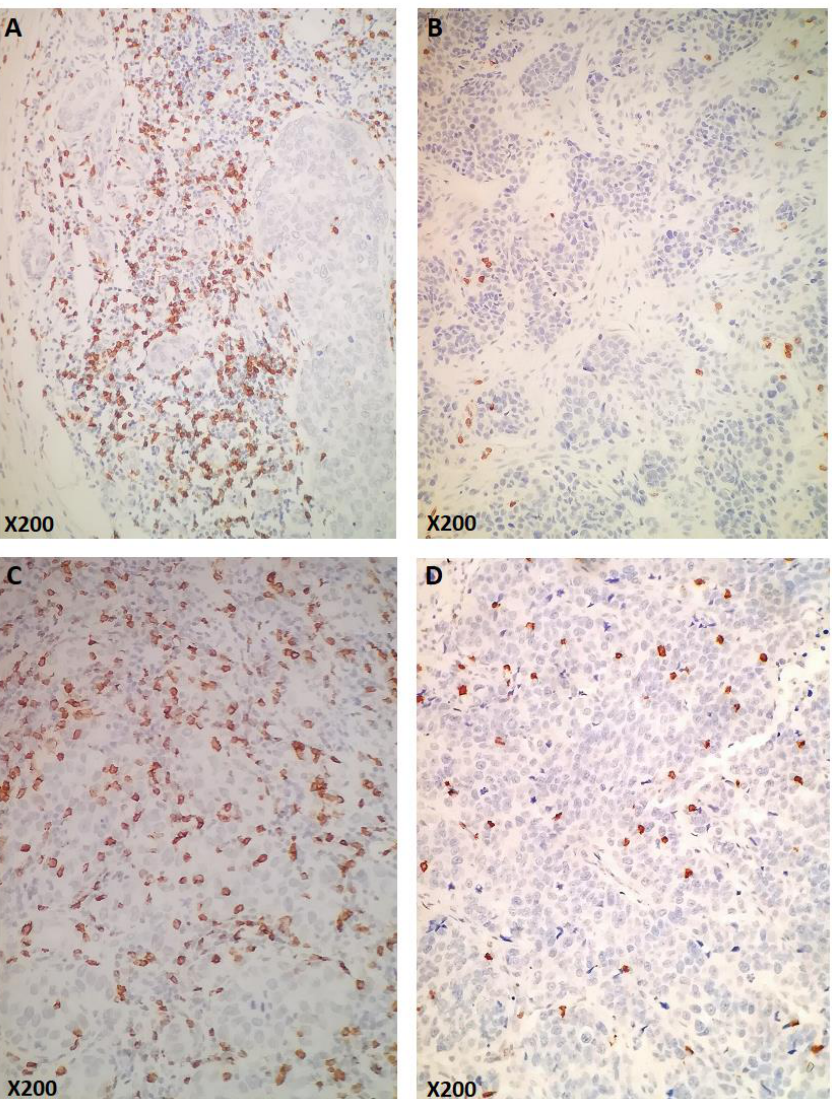
Figure 2. Examples of CD8 immunohistochemical expression (original magnification as indicated).